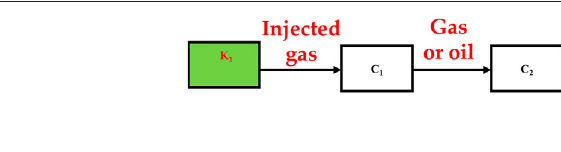
FIGURE 4 | Multi-stage contact process.